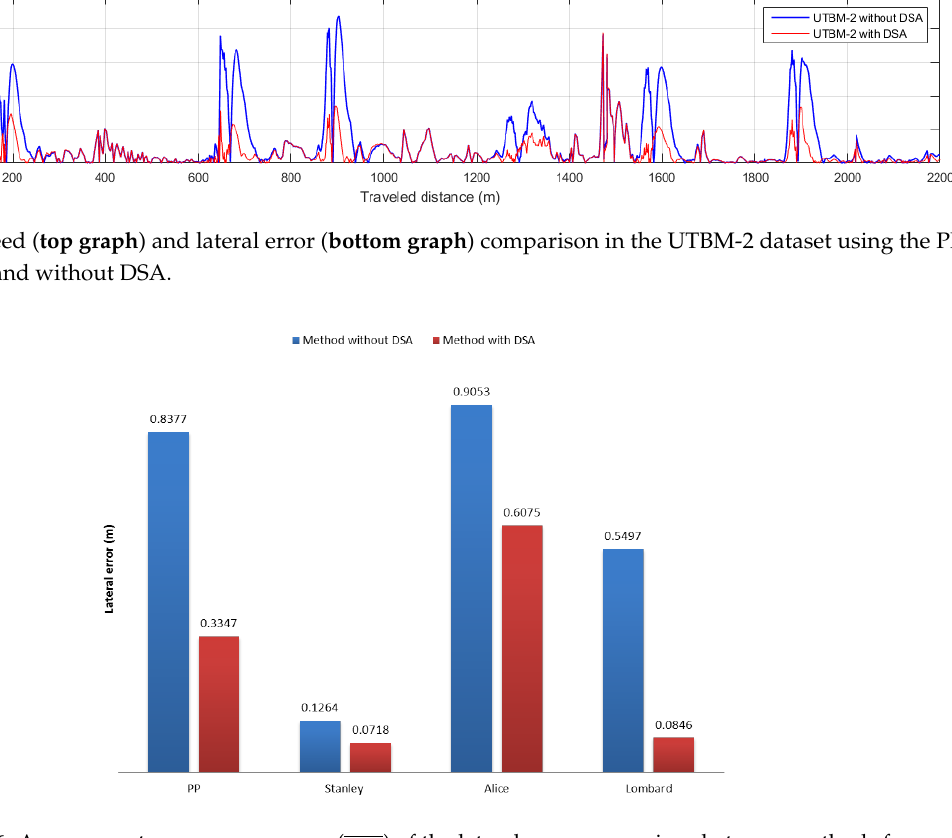
Figure 16. Average root mean square error ( e rms ) of the lateral error comparison between methods for sharp